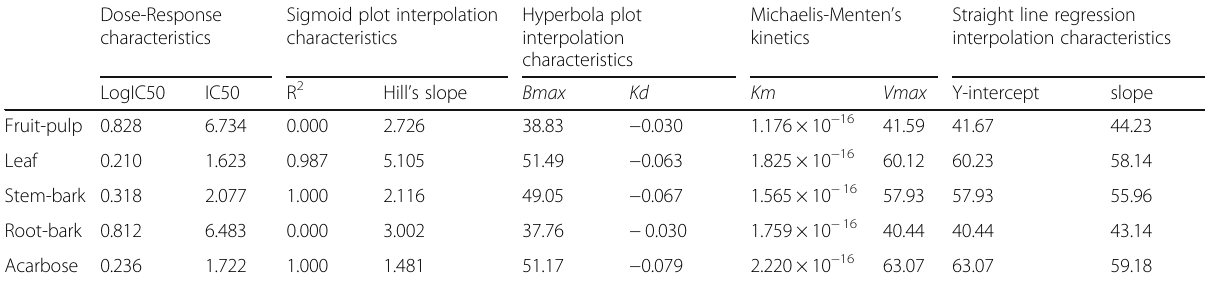
Table 6 Dose-response characteristics of the influence of Annona muricata methanol extracts on α -glucosidase activity Dose-Response